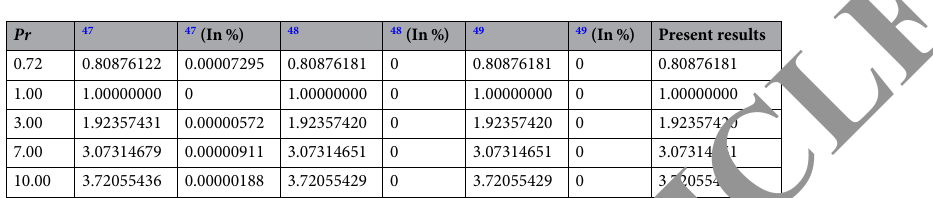
Table 3. Comparative variation of